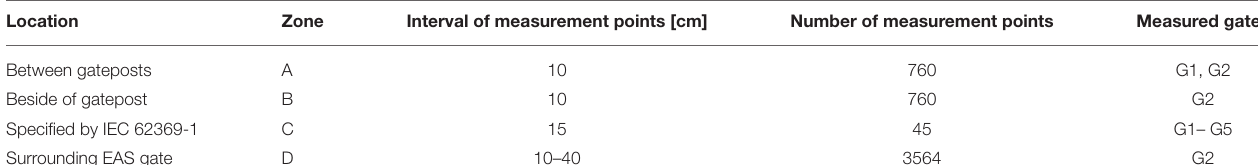
TABLE 2 | Measurement intervals and numbers measurement points in each zone.